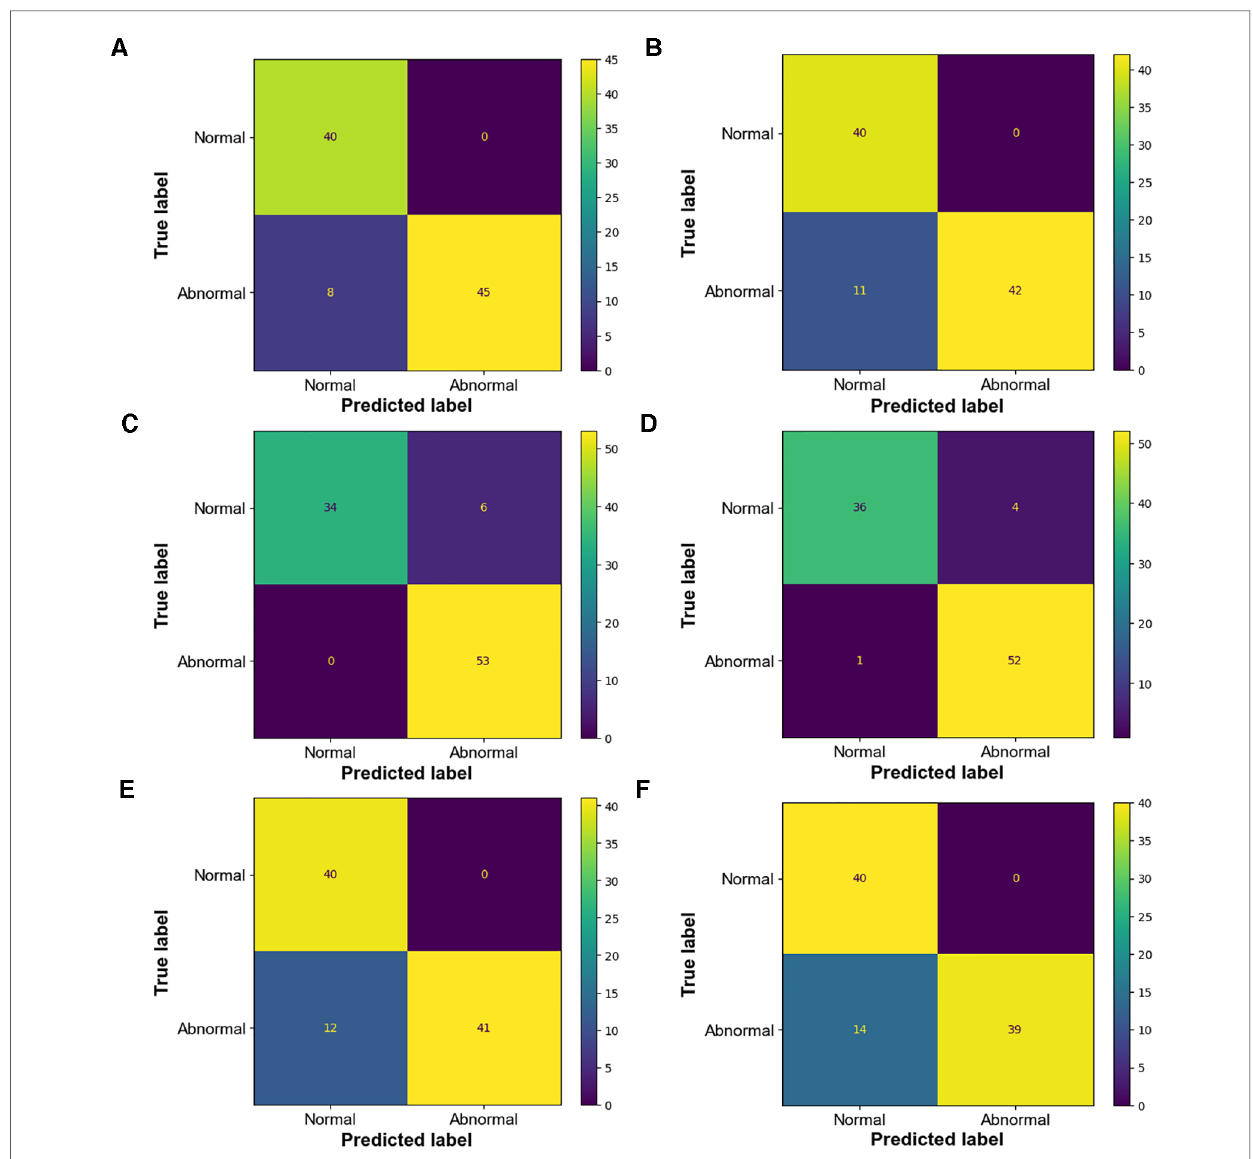
FIGURE 9 Confusion matrix of diagnostic results ( A ) confusion matrix of manual measurement diagnosis based on CHD database classi fi cation ( B ) confusion matrix of intelligent measurement diagnosis based on CHD database classi fi cation; kappa=0.84 ( C ) confusion matrix of manual measurement diagnosis based on Karl ’ s classi fi cation ( D ) confusion matrix of intelligent measurement diagnosis based on Karl ’ s classi fi cation; kappa=0.93 ( E ) confusion matrix of manual measurement diagnosis based on Langley ’ s classi fi cation ( F ) confusion matrix of intelligent measurement diagnosis based on Langley's classi fi cation;